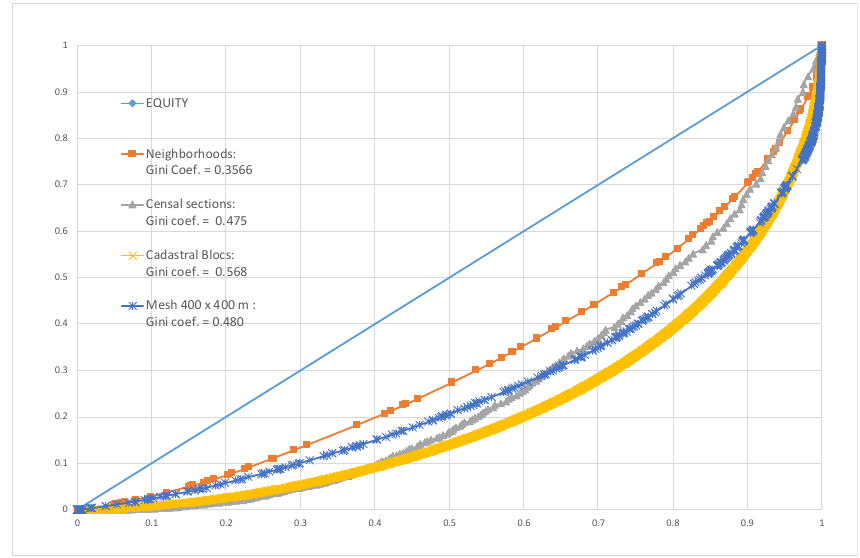
Figure 6. Lorenz curve of the distribution of the bus service level and Gini coefficients.